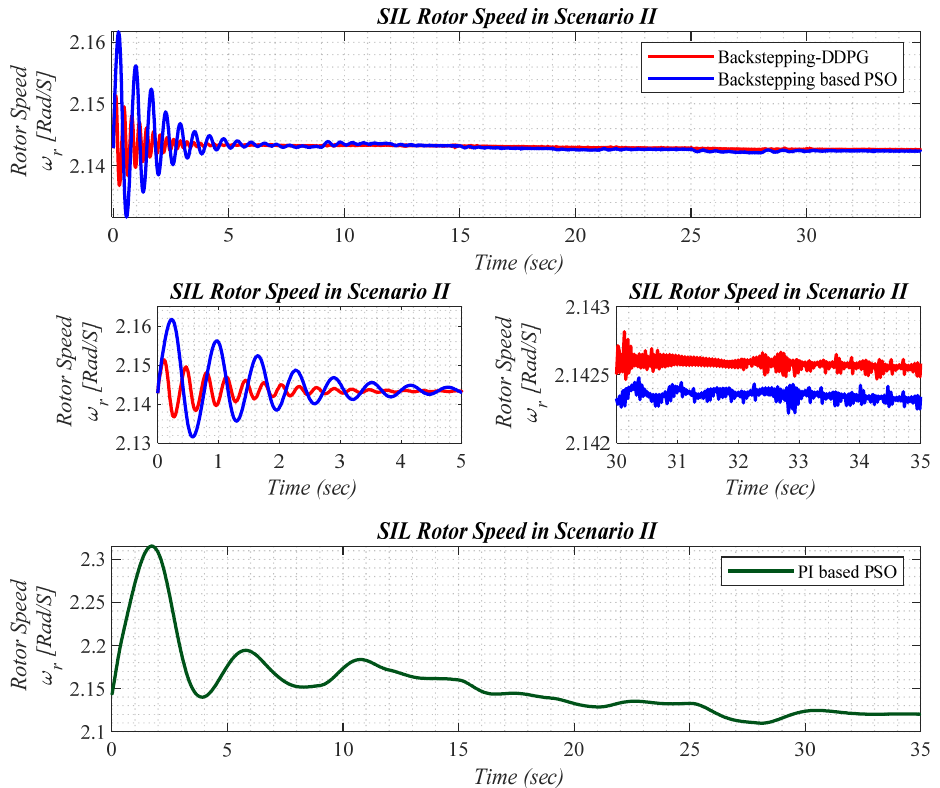
Figure 13. SIL output comparative results of backstepping controller based DDPG, backstepping controller based PSO and PI controller based PSO according to Scenario II.